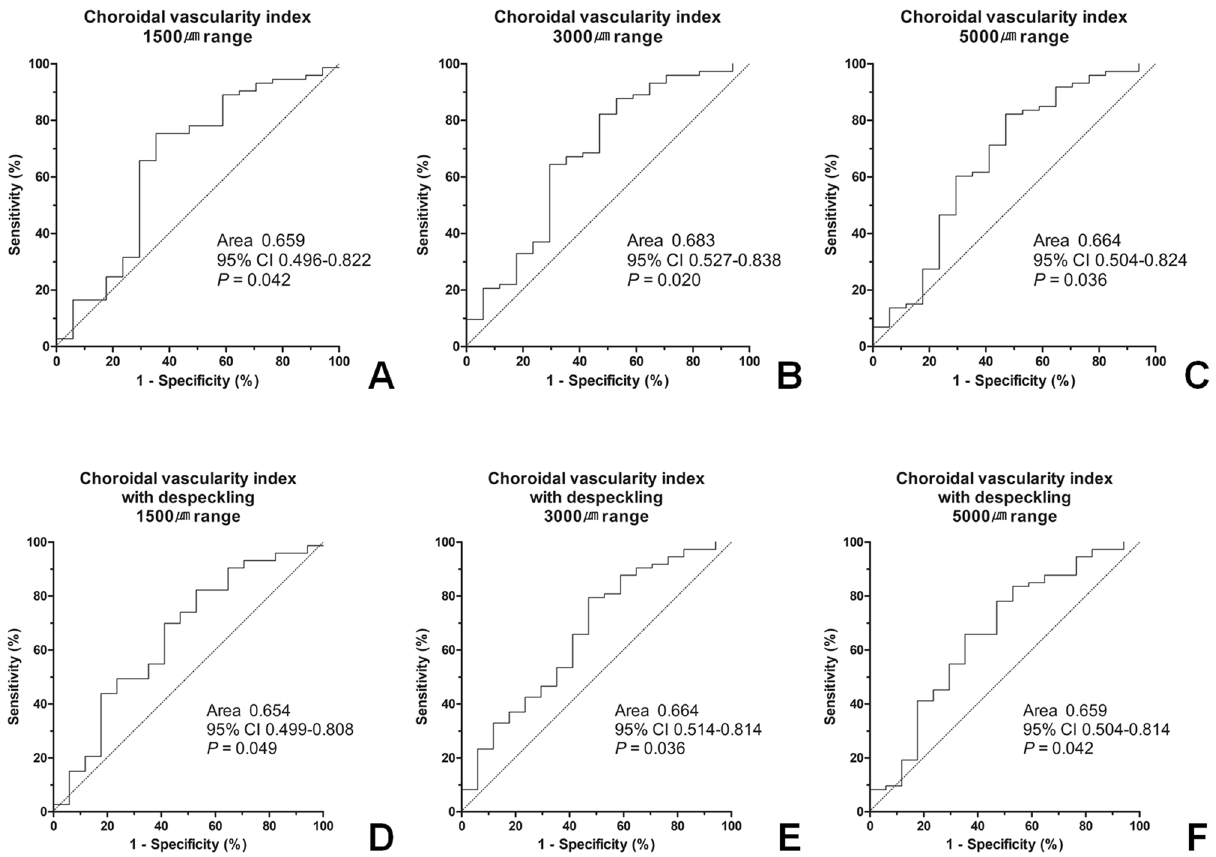
Figure 2. Receiver operating characteristic curve for predicting triple vessel disease using the choroidal vascularity index. The maximum sum of sensitivity and specificity was observed with CVI value cut-off points of 0.604, 0.601, and 0.600 for CVI without despeckling in 1500 μm, 3000 μm, and 5000 μm range analyses, respectively, and CVI value cut-off points of 0.624, 0.630, and 0.628 for CVI with despeckling in 1500 μm, 3000 μm, and 5000 μm range analyses, respectively. CI = confidence interval.